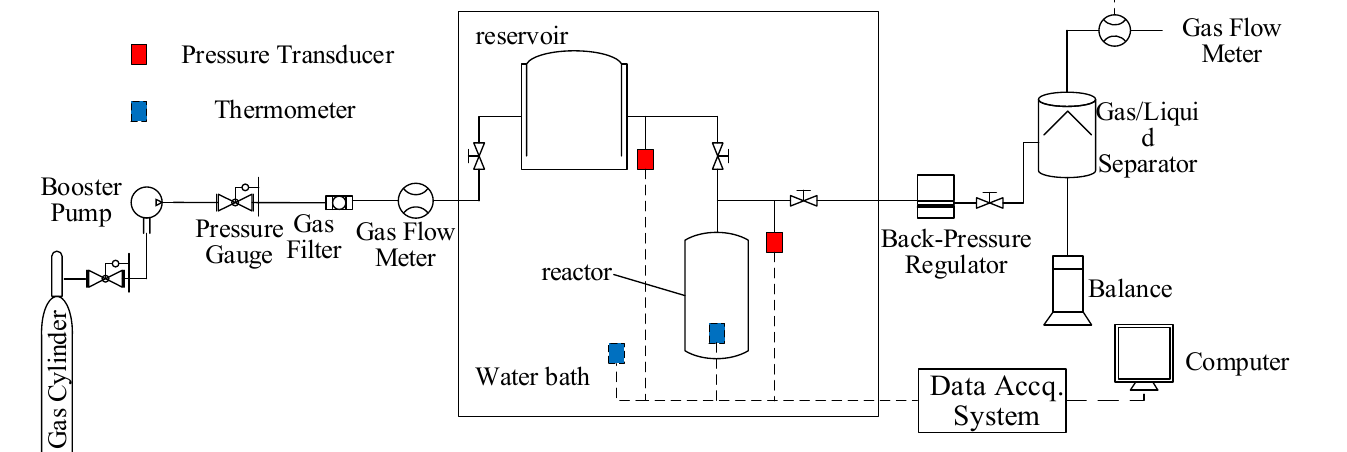
Figure 1. Schematic of the experimental apparatus.